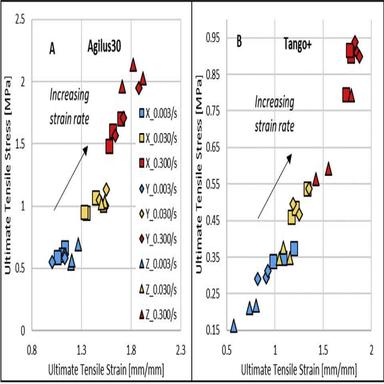
Ultimate tensile stress and strain of A30 (left) and T+ (right) at various strain rates.